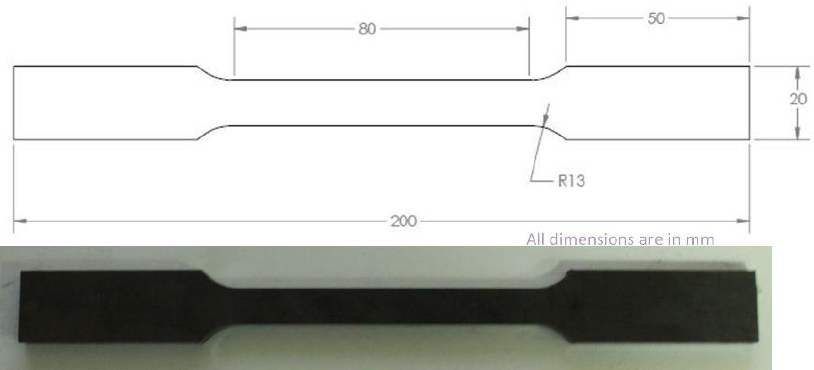
Figure 2. Tensile testing sample.